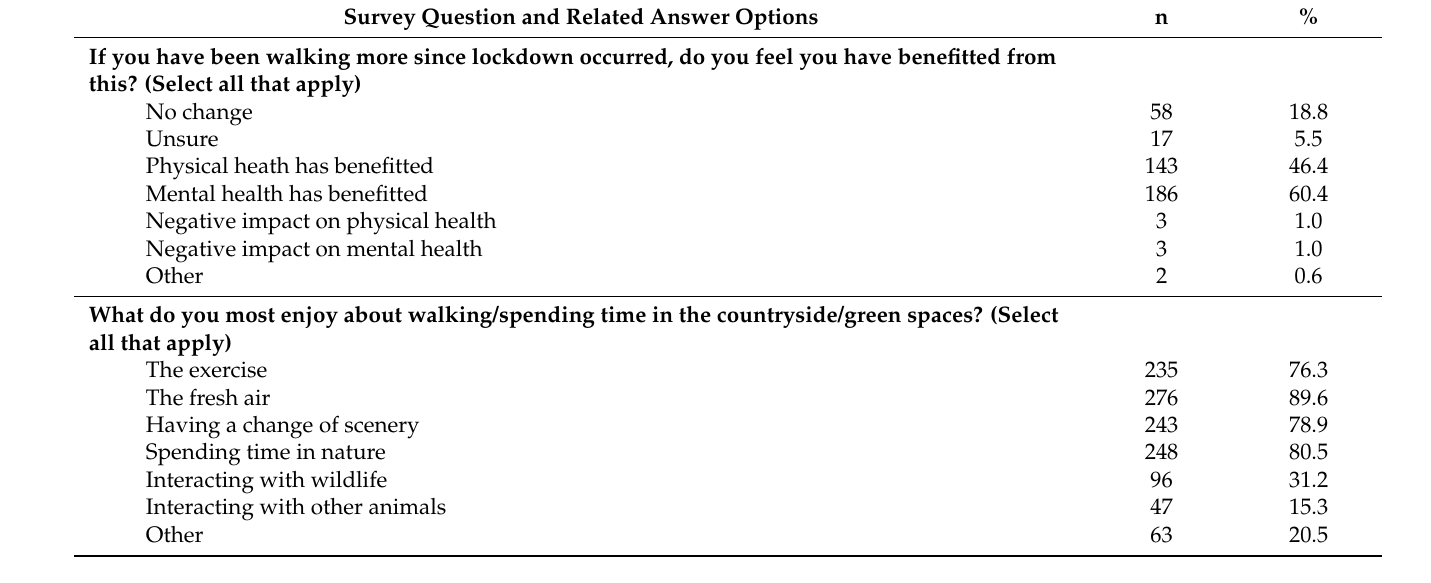
Table 4. Respondent answers to questions relating to beneficial effects of walking and what they enjoy most about being